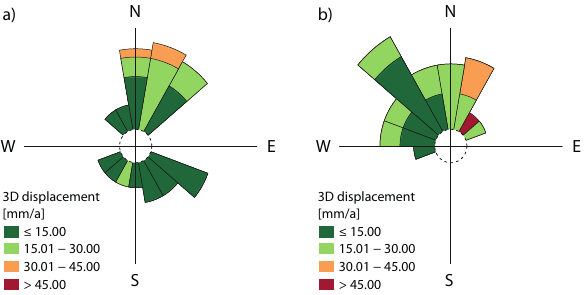
Figure 7. Classified direction and magnitude of the annual displacement vectors derived from the laser scanning data (a) and the ATTS (b).